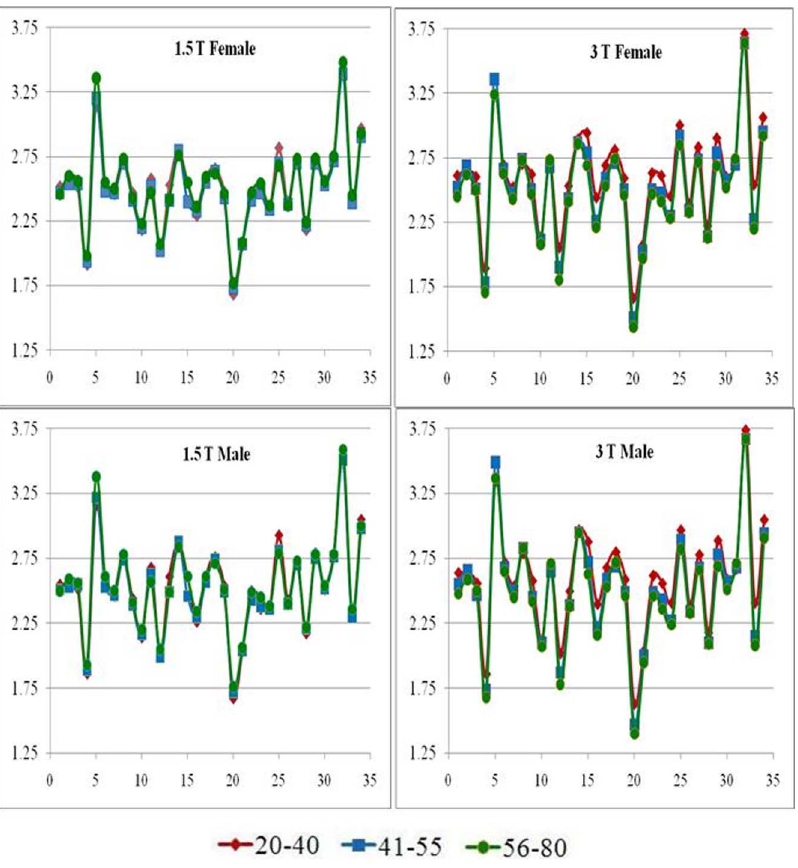
Figure 4. Regional cortical thickness of the 34 segmented regions plotted for the three age groups.